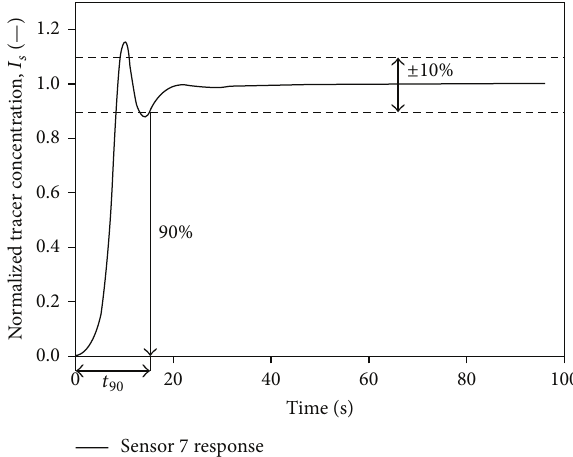
Figure 6: A graphical representation of 𝑡 90 mixing time using the simulated concentration response by Bujalski et al. 2002